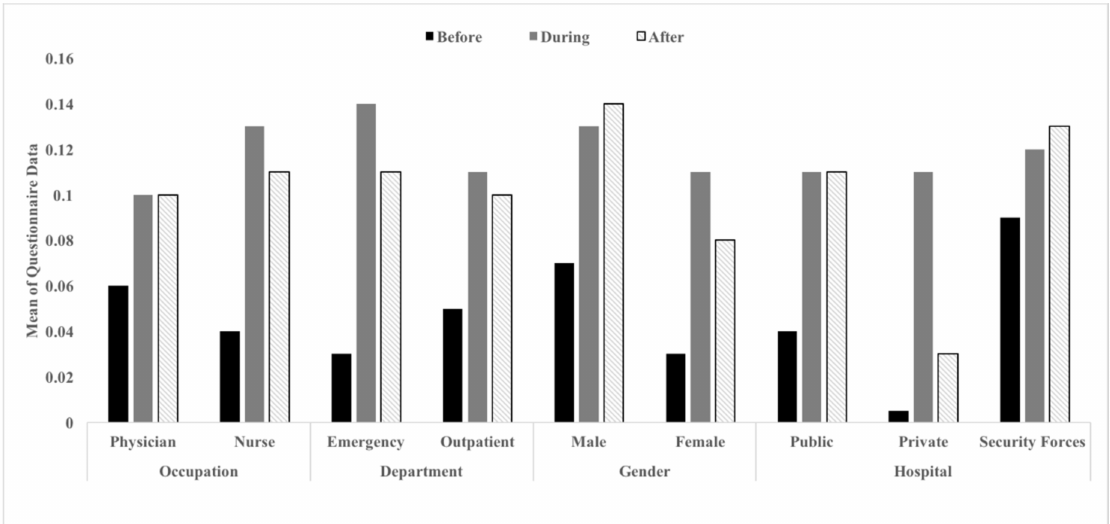
Figure 1. Comparing the mean scaled compliance scores of all variables based on the observation data. Note: Mean observation scores range from 0 to 1, with 1 being compliance 100% of the